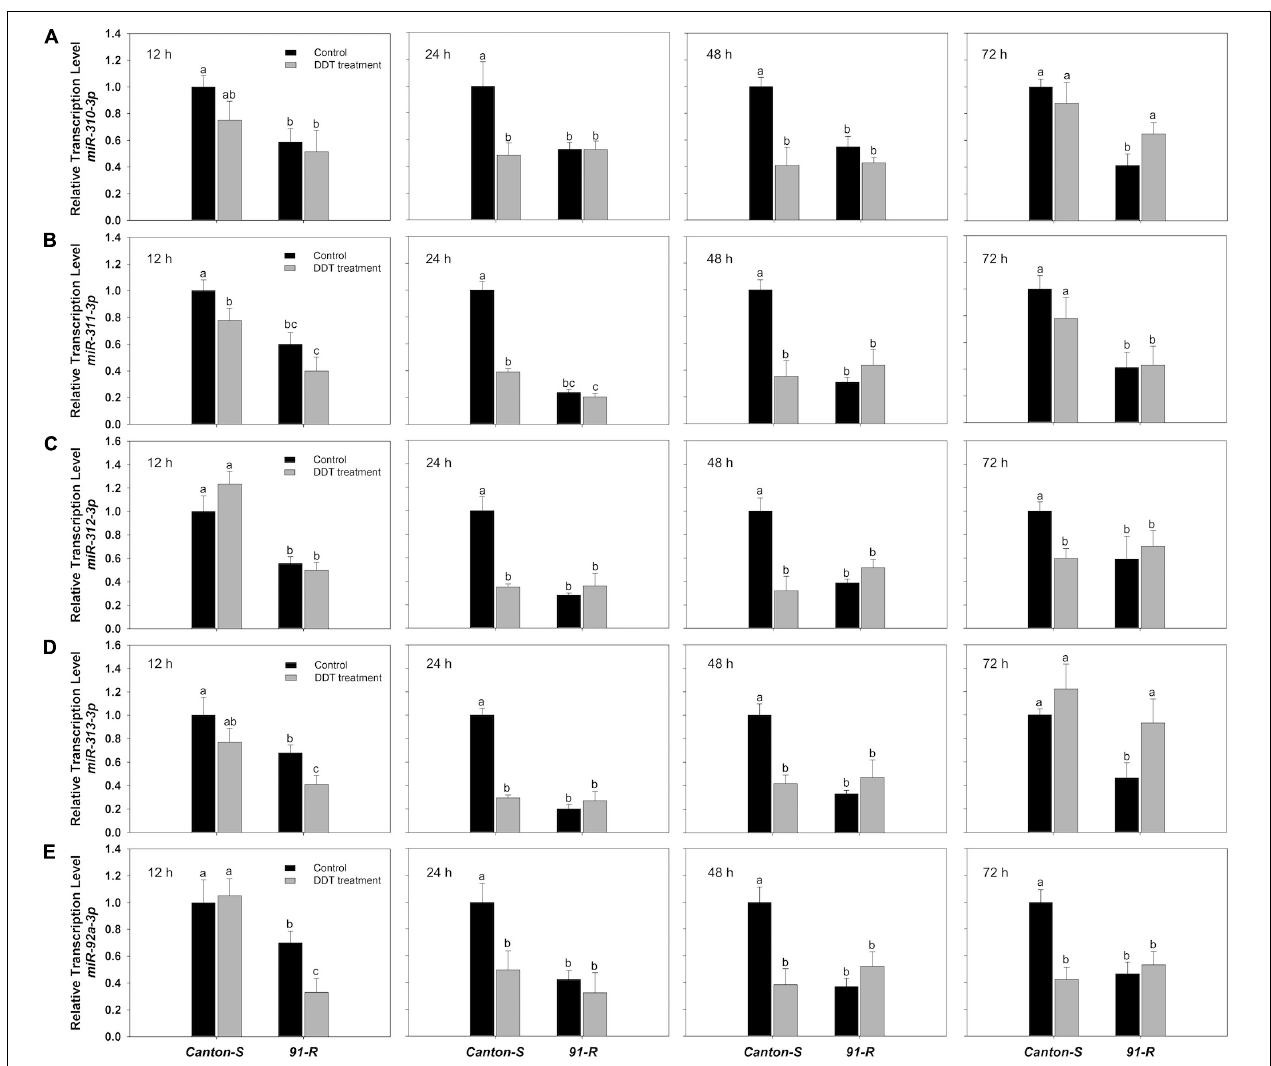
FIGURE 1 | The expression of miR-310 family, (A) miR-310 , (B) miR-311 , (C) miR-312 , (D) miR-313 , and (E) miR-92a , in DDT-resistant 91-R and the DDT-susceptible Canton-S strains following DDT exposure. The induction or repression level of expression were analyzed 12, 24, 48, and 72 h after DDT exposure. The relative levels of gene expression shown along the Y axis represent the ratio of the gene expression in each treatment compared to the acetone-treated Canton-S strain. The experiments were repeated three times. The vertical bars indicate standard error of the mean (SEM). Different letters on the bars indicate that the means are significantly different throughout the strains where the P -value <